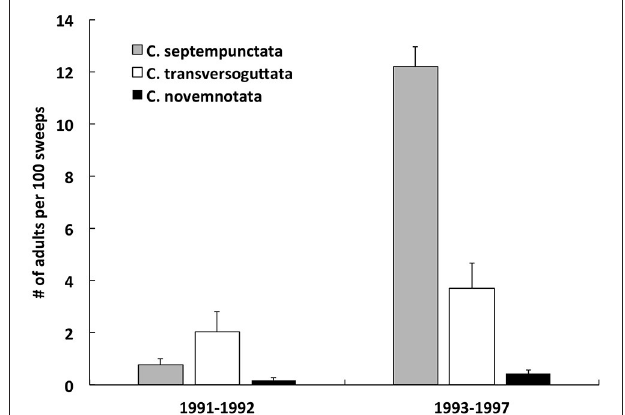
FIGURE 2 | The number of adults of Coccinella spp. ( C. septempunctata , C. tranversoguttata , and C. novemnotata ) per 100 sweeps in plots of alfalfa (one half of which were sprayed with sugar solution) during field experiments conducted in northern Utah (Cache Valley) in 1991–1992 and in 1993–1997. Differences in the abundance of individual species between the two periods were not significant (one-way ANOVA).